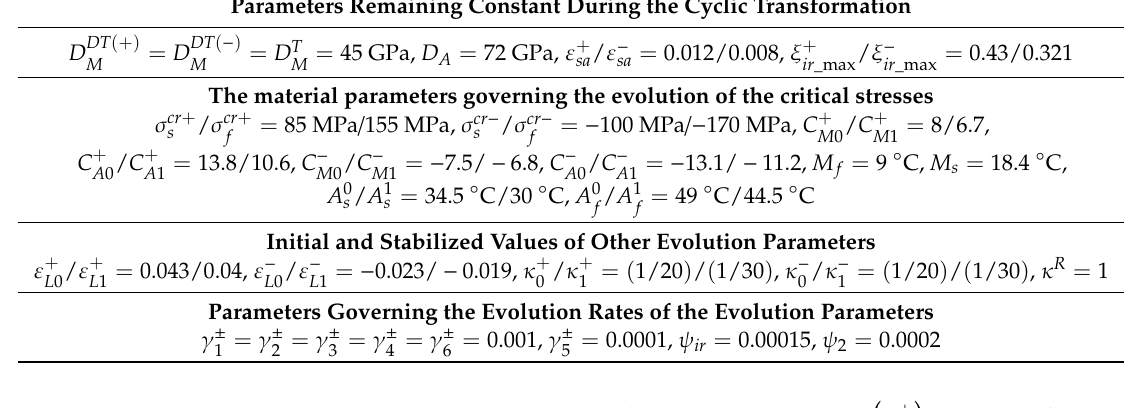
Table 4. Material parameters used in the proposed model for SMAs at various temperatures. (NiTi-Cu alloys).